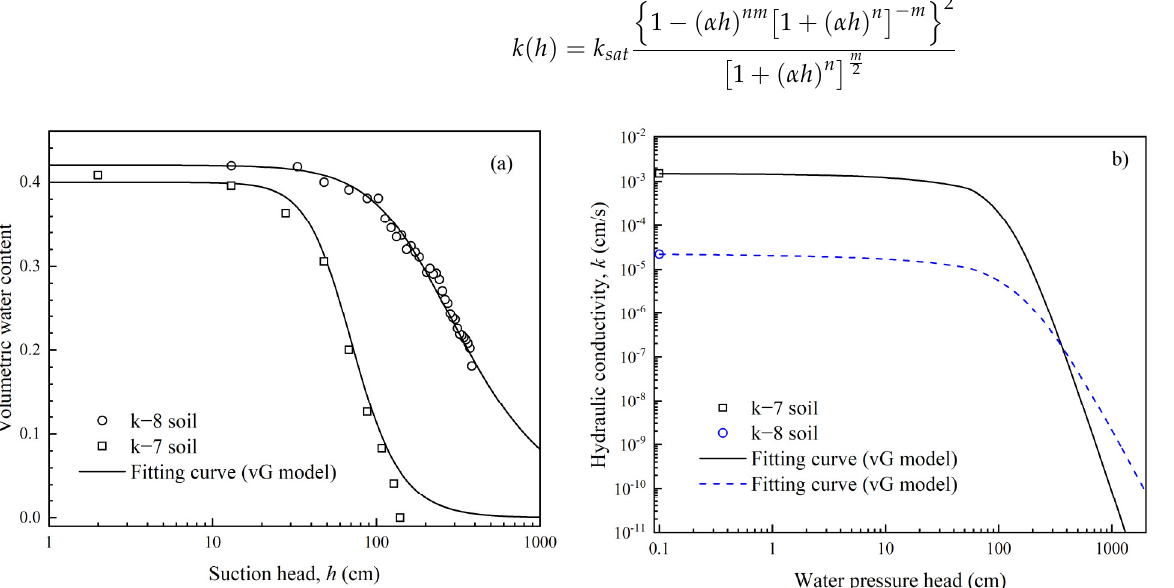
Table 1. Parameters applicable to the main wetting curve.